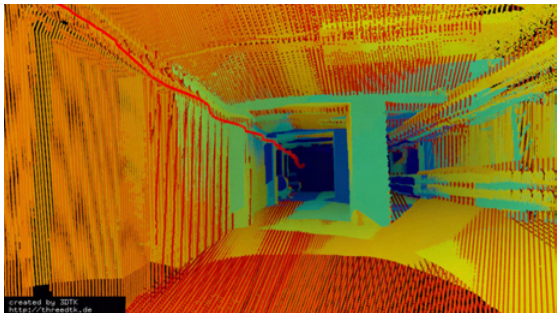
Figure 9: 3D point cloud acquired by the backpack system after applying semi-rigid SLAM. Details are given in Elseberg et al., 2013